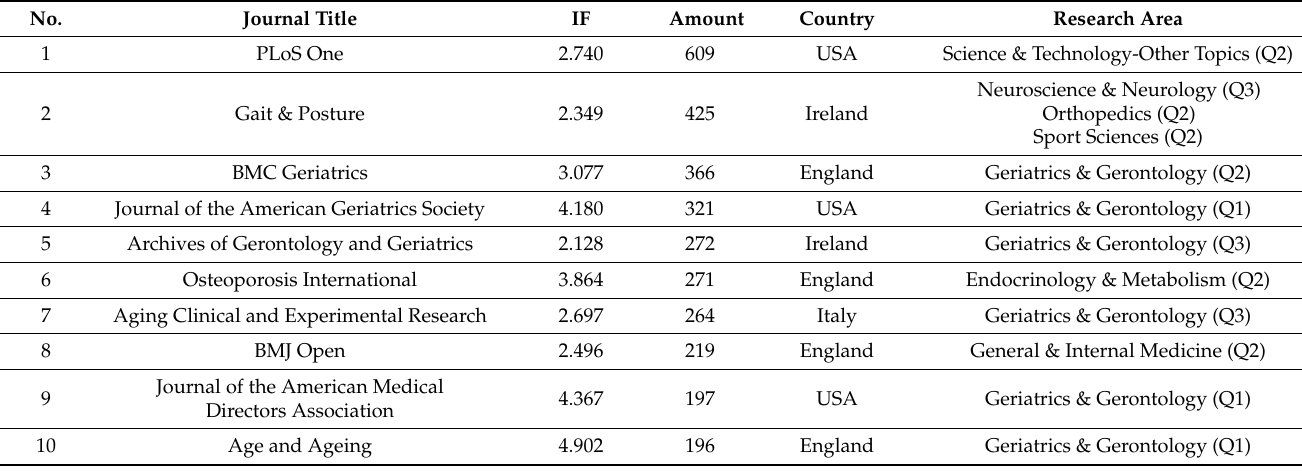
Table 1. Top 10 journal published analysis